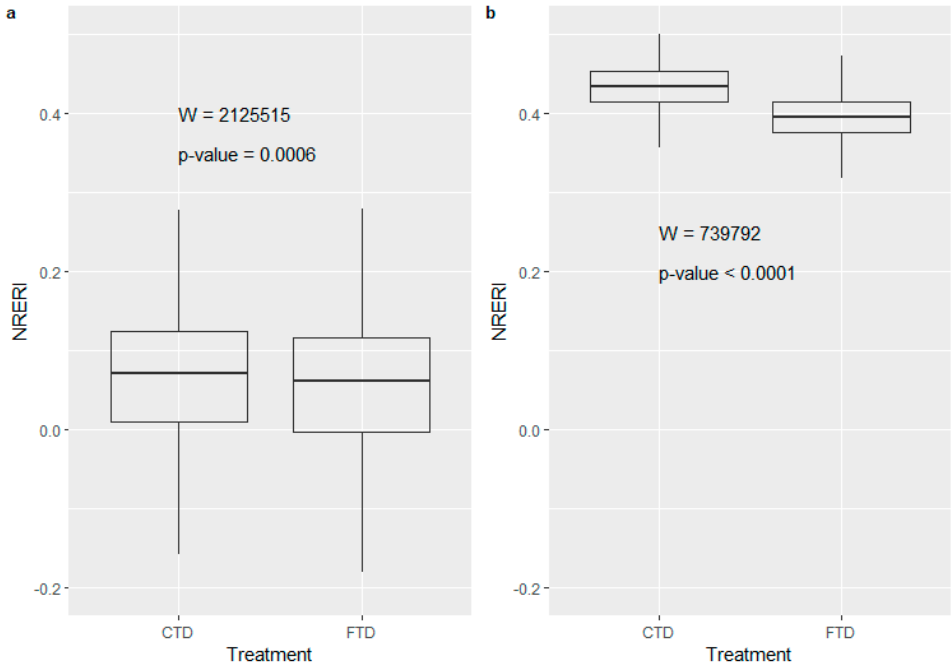
Figure 6. NRERI box plots with Mann-Whitney U test (W, p-value) at CTD and FTD sites with